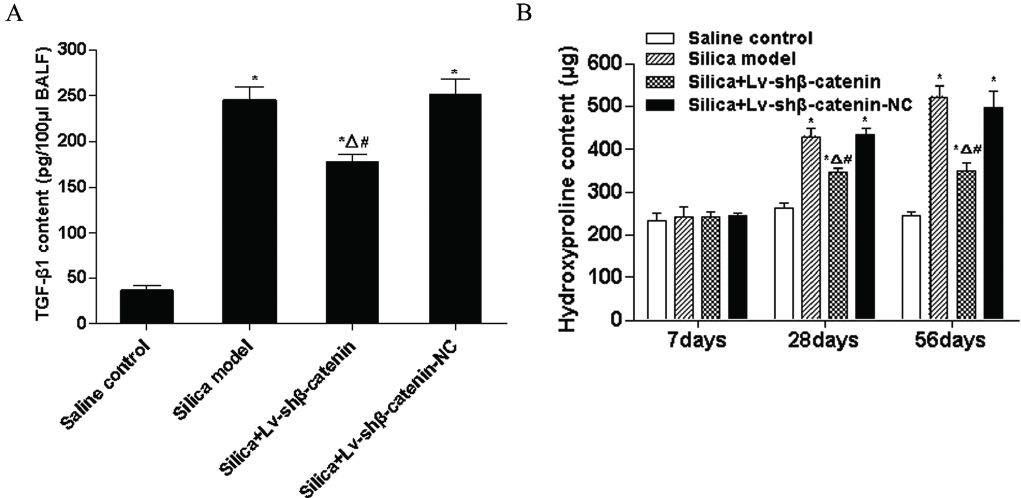
Figure 4. TGF- β 1 level in BALF and hydroxyproline content in the lung of mice instilled with silica. ( A ) The level of TGF- β 1 in BALF detected by ELISA at 7 days after silica instillation. ( B ) Hydroxyproline content in the lung of mice at different time point after silica instillation. Data are mean ± SEM (n = 6). * p < 0.05, compared to the saline control group; Δ p < 0.05, compared to the silica group; # p < 0.05, compared to the silica + Lv-sh β -catenin-NC